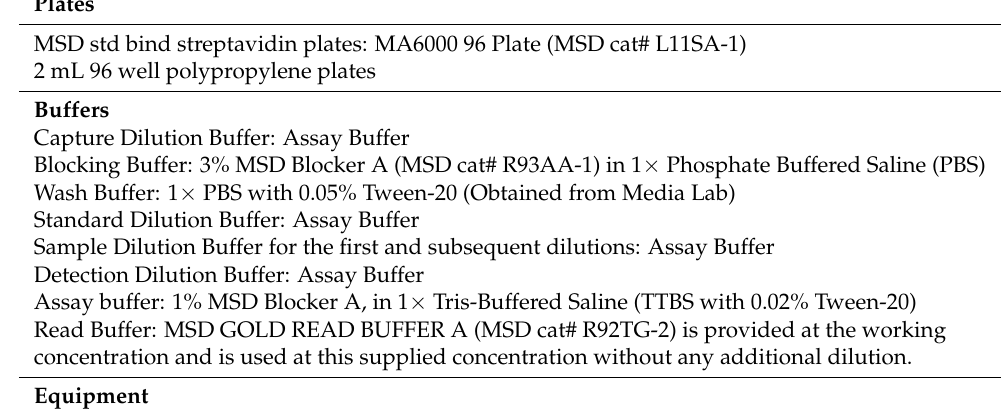
Table 2. Meso Scale Discovery (MSD)-based ligand-binding assay for pharmacokinetics (PK) analysis.